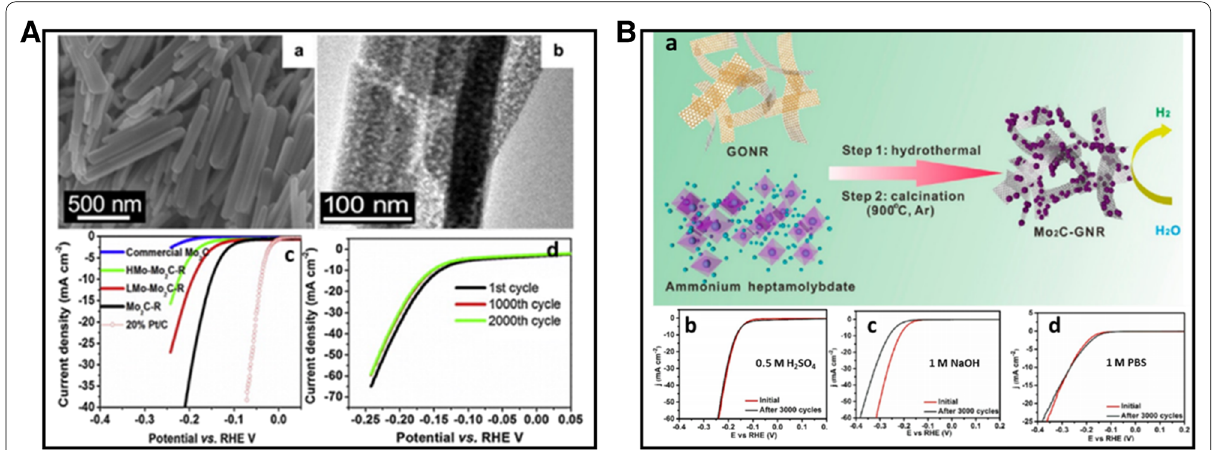
Fig. 6 A (a) FESEM image of Mo 2 C‑R, (b) SEM image of Mo 2 C‑R, (c) polarization curves in 0.5 M H 2 SO 4 , and (d) stability test of Mo 2 C‑R in 0.5 M H 2 SO 4 (Figure reprinted with permission from Ref. [38]). B (a) Preparation of molybdenum carbide (Mo 2 C) nanoparticles anchored on graphene nanoribbons (GNRs), and (b–d) activity and durability of Mo 2 C‑GNR in acidic, basic, and neutral media, respectively (Figure reprinted with permission from Ref.